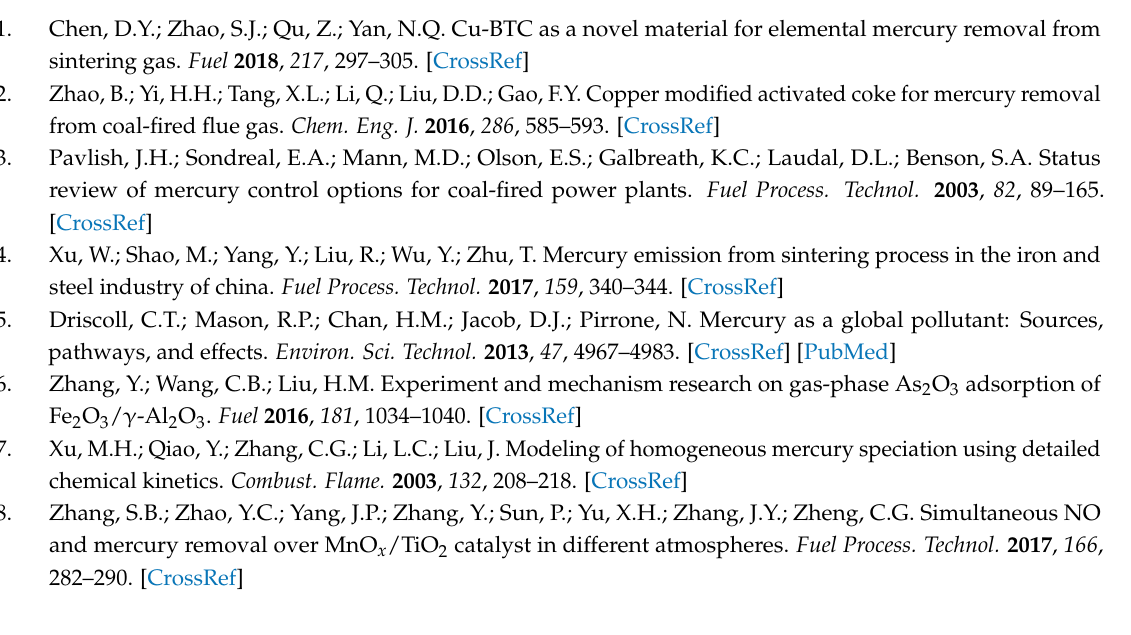
Figure S1: The element contents on the surface of graphene (EDS) and SEM images of Ce-Mn-Fe/GO0, Figure S2: The element contents on the surface of graphene (EDS) and SEM images of Ce-Mn-Fe/GO-0.1, Figure S3:The element contents on the surface of graphene (EDS) and SEM images of Ce-Mn-Fe/GO-0.3, Figure S4: NO x conversion as a function of reaction temperature over the Ce-Mn-Fe/GO-x (x = 0, 0.1, 0.3) samples. (Reaction conditions: 800 ppm NO, 800 ppm NH 3 , 6% O 2 and N 2 balance, GHSV = 30,000 h − 1